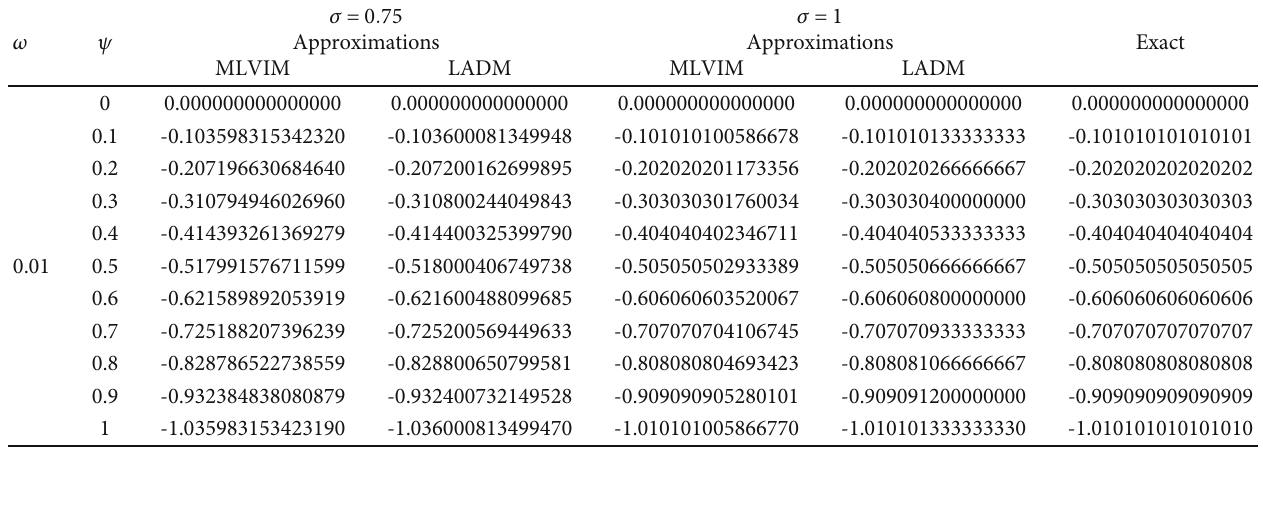
Table 2: Comparison of LADM and MLVIM solution for the fi rst three approximations with exact solution for ω = 0 : 2 , with mesh points ψ = 0 : 1 , for equation (33).